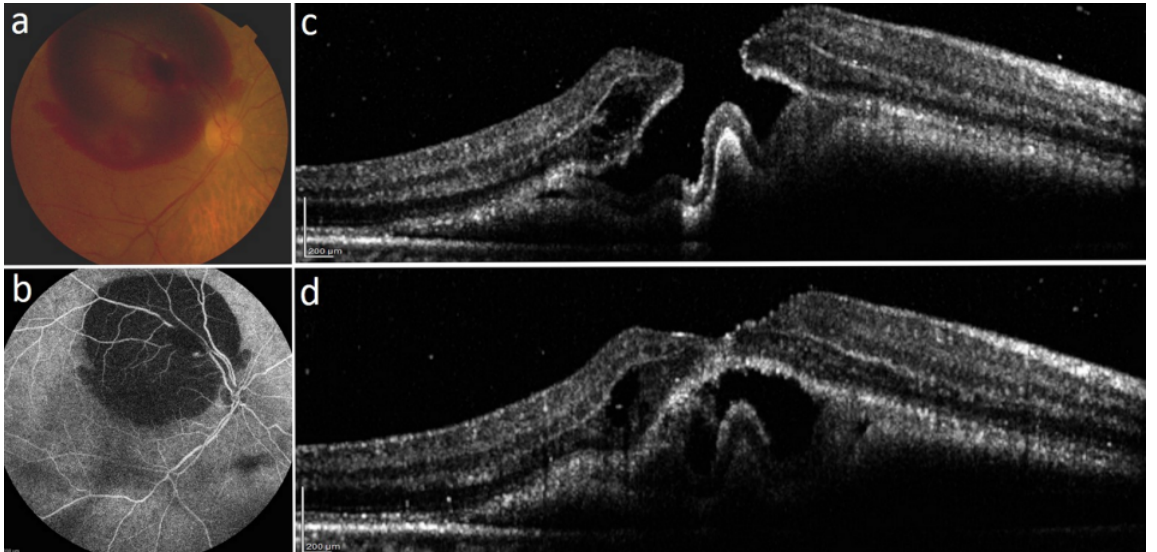
Figure 1: a) The clinical photograph of the right eye demonstrates the presence of a full-thickness macular hole and massive multilevel retinal hemorrhage secondary to a ruptured retinal arterial macroaneurysm in the superotemporal arcade area. b) The fluorescein angiography study confirms the presence of a retinal arterial macroaneurysm in the superior temporal arcade. c) and d) show optical coherence tomography scans with 3-D reconstruction confirming the macular hole 600 µm in diameter.